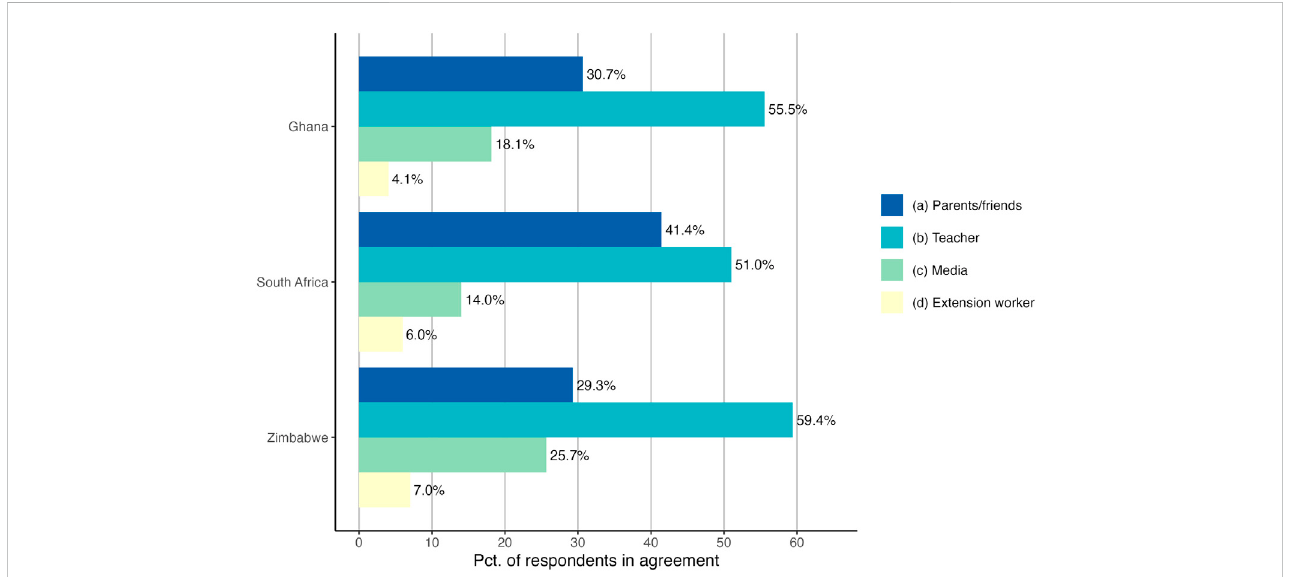
FIGURE 3 Information sources of soil care from the ‘ ABC of Soil ’ survey. Taken from Johnson et al (2020).